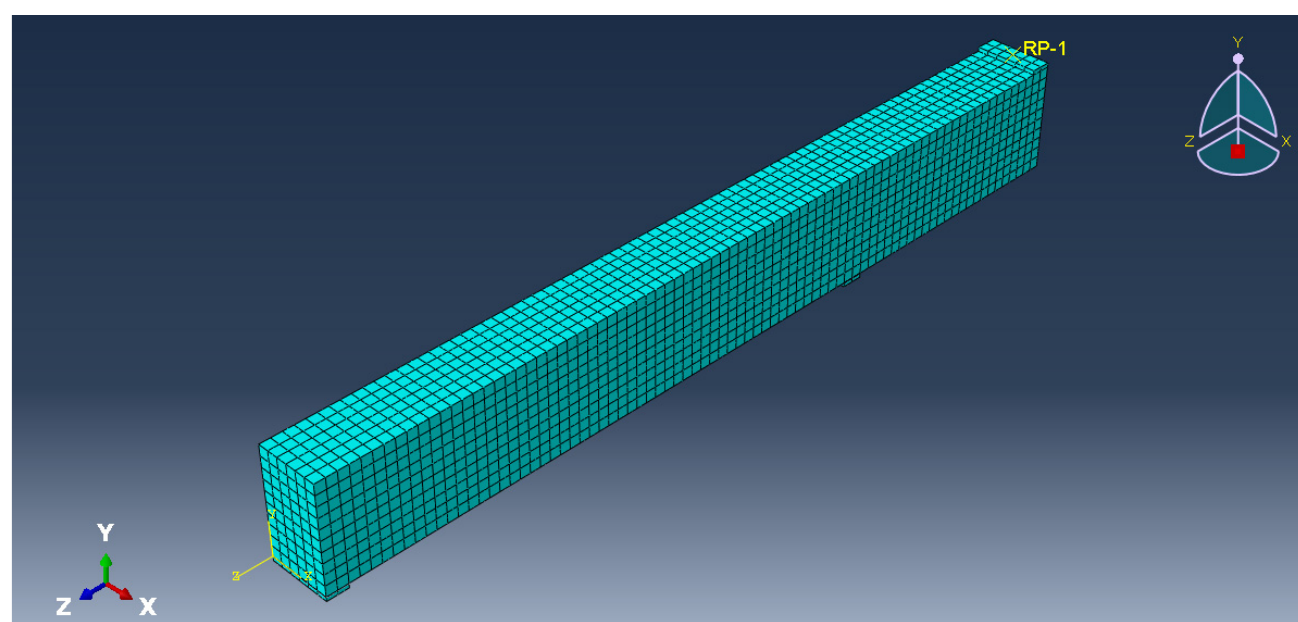
Figure 2. Reference point and finite element meshing.